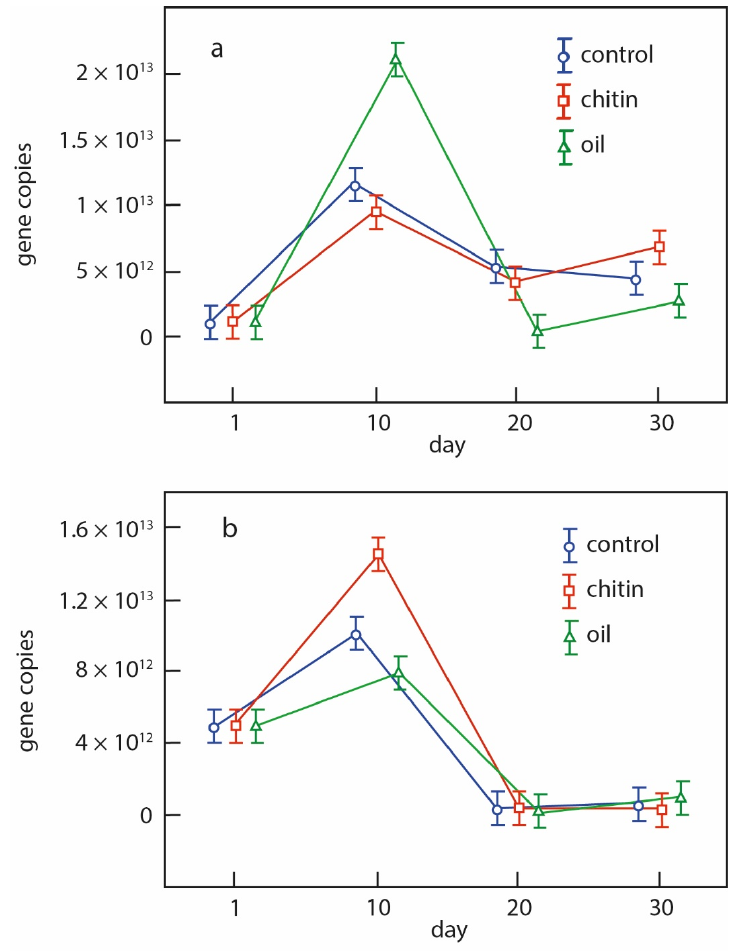
Figure 5. Dynamics of 16S RNA bacterial gene copy number with and without substrate addition: k—control; x—chitin; n—oil in different horizons of volcanic stratified ochre soil: ( a ) in the modern horizon (LS means. Current effect: F(6, 12) = 48.215; p = 0.00000. Decomposition of III types. Vertical bars denote 0.95 confidence intervals); ( b ) in the buried horizon (LS means. Current effect: F(6, 12) = 15.926; p = 0.00004. Decomposition of III types. Vertical bars denote 0.95 confidence intervals).